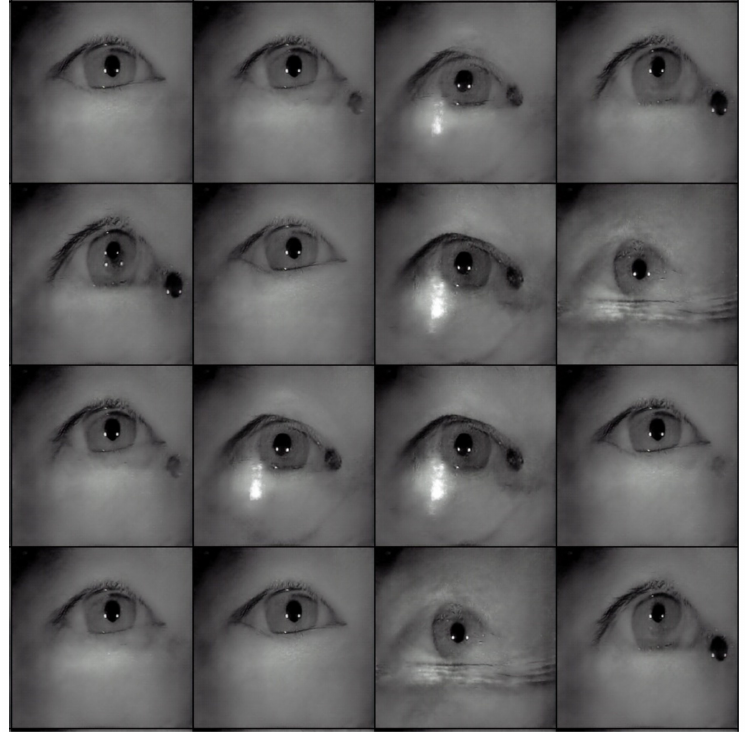
Figure 22. The example of generated images by Yadav et al.